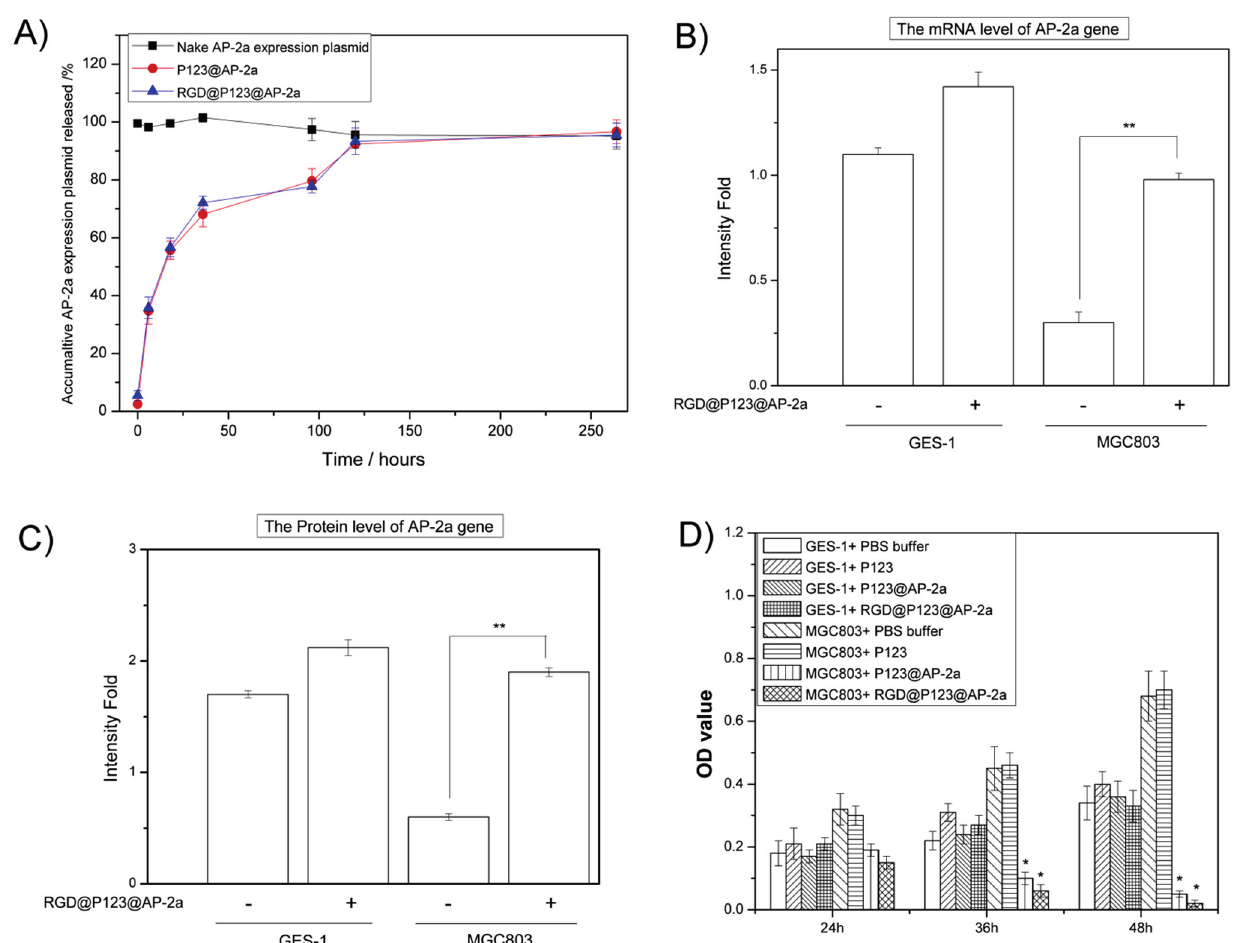
Figure 2. ( A ) Control release profiles of Activating protein 2 α family (AP-2 α ) expression plasmids form RGD modified P123 nanoparticles; ( B ) mRNA and ( C ) protein